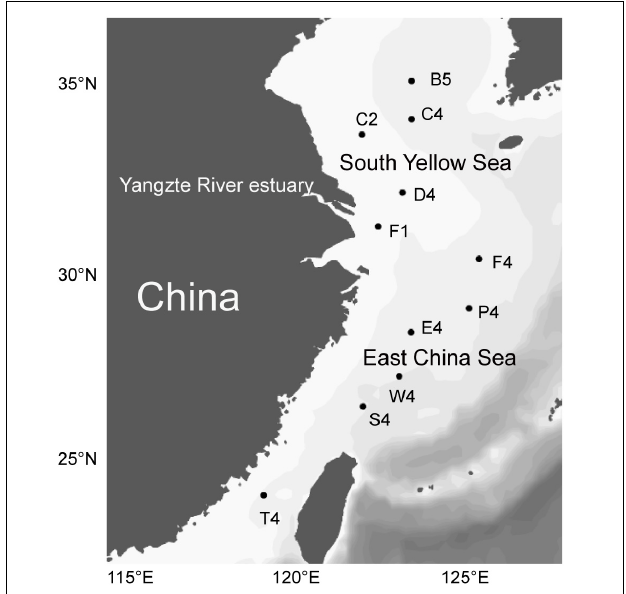
FIGURE 1 | Sampling stations in the southern Yellow Sea and East China